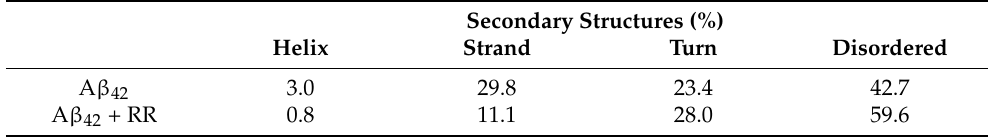
Table 2 . Predicted secondary structures based on the CD test. Table 2. Predicted secondary structures based on the CD test.